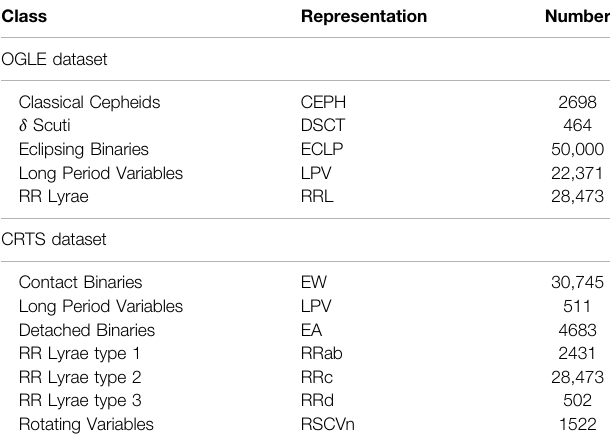
TABLE 1 | Summary of light curves belonging to different variability classes obtained from the OGLE and CRTS surveys. The number of samples belonging to different classes in the last column have been adopted from the respective